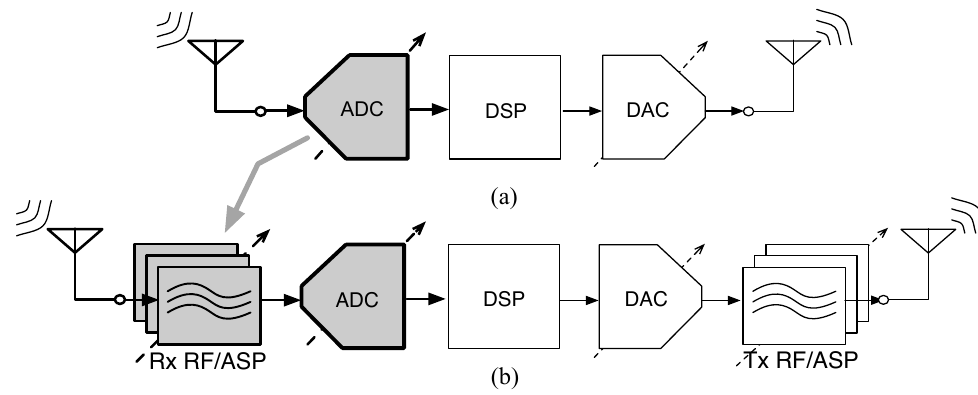
Figure 1. Software-defined radio transceiver. ( a ) Ideal concept. ( b ) Including RF/ASP